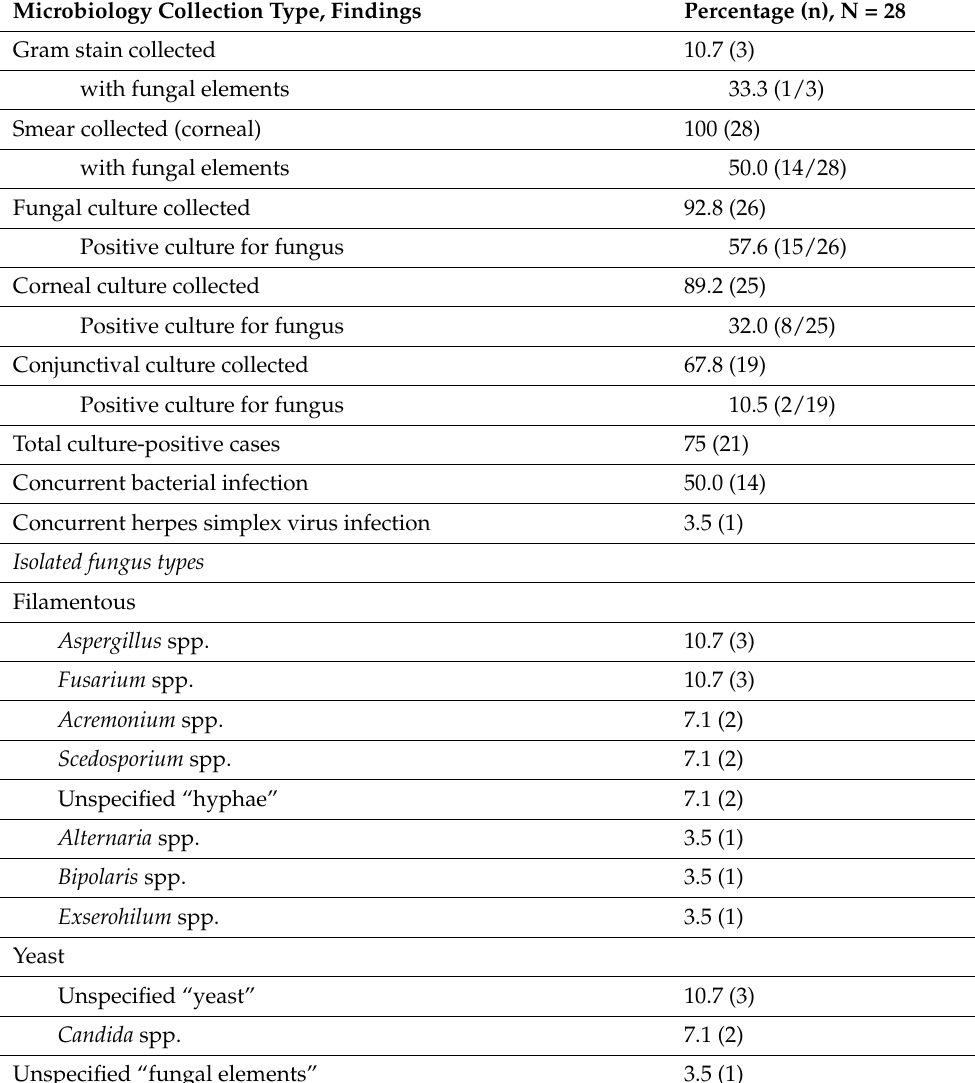
Table 3. Microbiological profile of patients with fungal